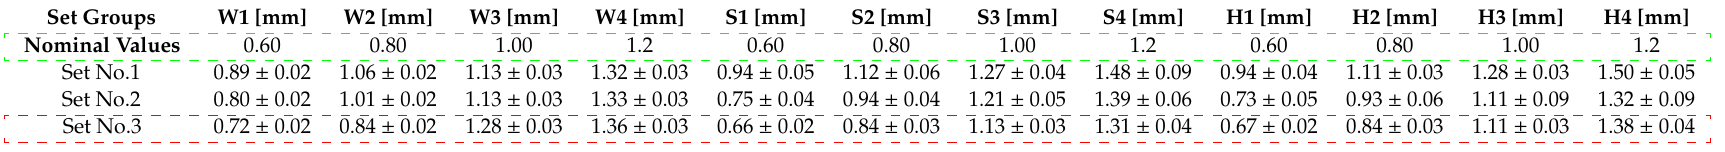
Table 4. Results of wall thickness measurements depending on applied 3D printing parameters set (green line—nominal dimensions, red lines – estimated values of wall